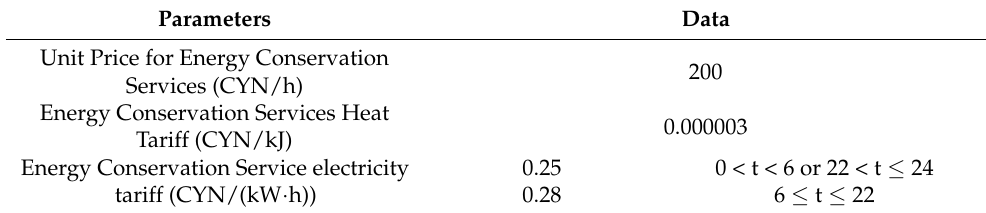
Table 8. The related parameters of energy conservation service in power retailers.